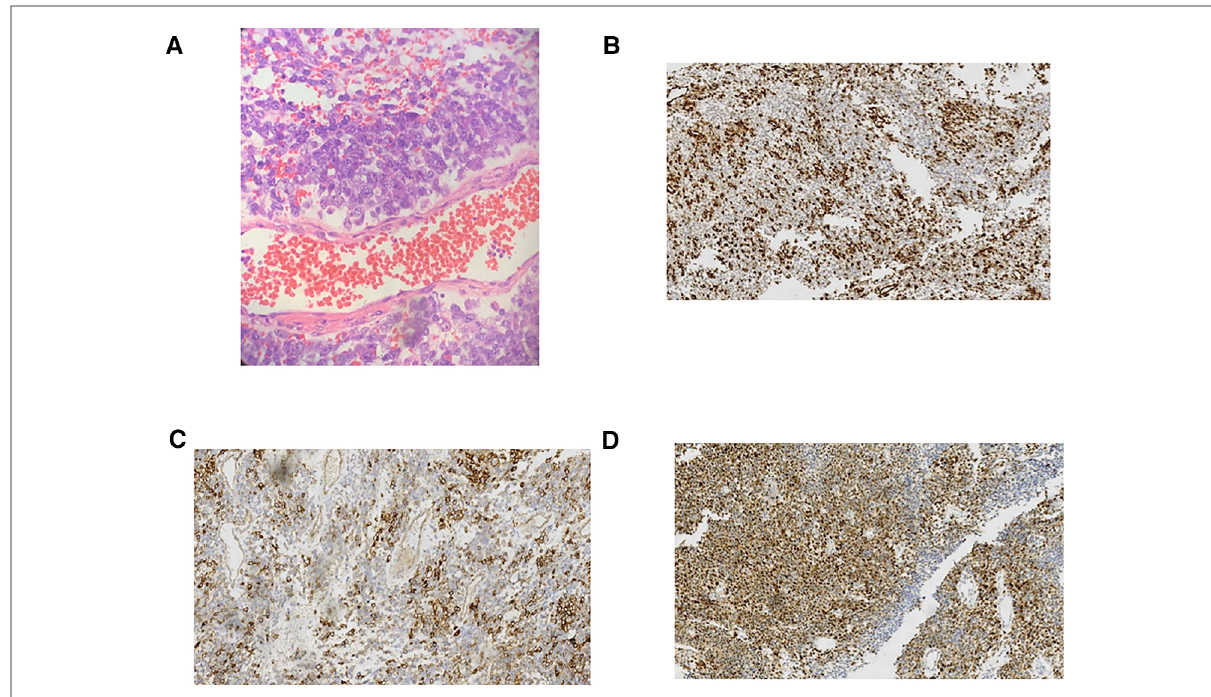
round blue cells immunohistochemical positivity for CD99, vimentin, and cyclin